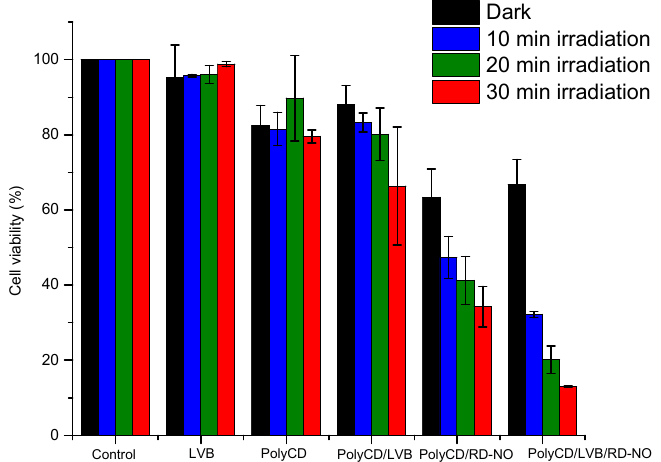
Figure 9. Cell viability was observed 24 h after incubating HEP-G2 hepatocarcinoma cells with free LVB, PolyCD, and the supramolecular complexes PolyCD/LVB, PolyCD/RD-NO, and PolyCD/LVB/RD-NO in the dark and upon different irradiation times (occurred after the first 4 h of incubation) at λ exc > 500 nm. [LVB] = 50 µM; [RD-NO] = 6 µM; [PolyCD] = 2 mg mL − 1 .